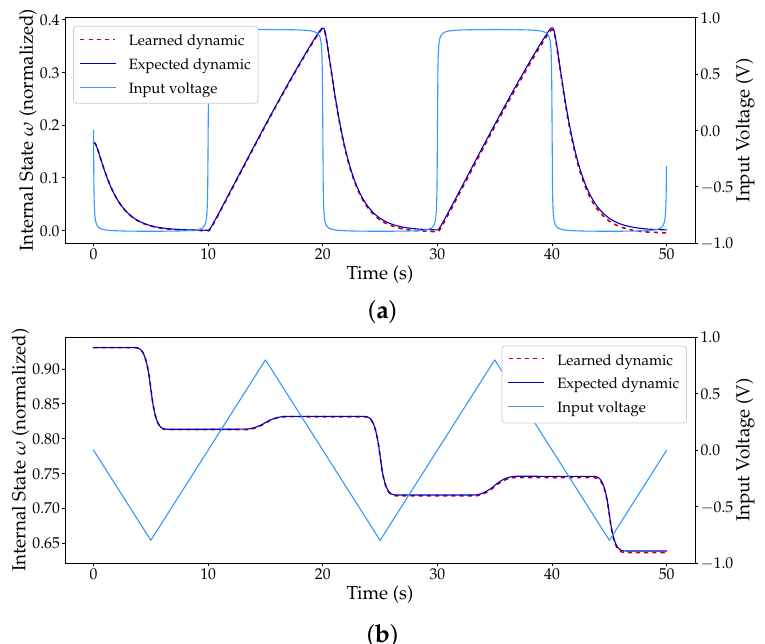
Figure 4. Expected dynamics of a simulated Pt-Hf-Ti memristor and the output of an MSNN network with external input and [ 2,50,50,50,1 ] topology. ( a ) Output of the network to a square-shaped periodic input. ( b ) Output of the network to a triangular-shaped periodic